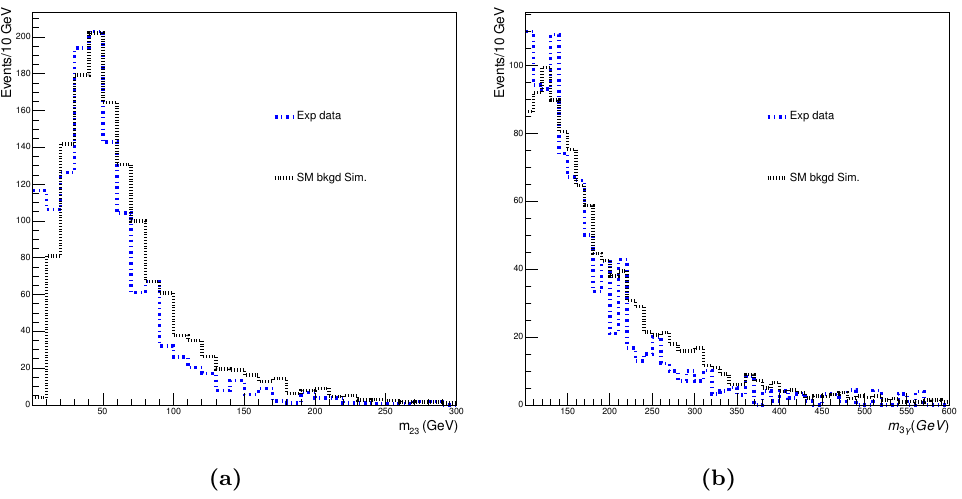
Figure 8. The comparison of the simulated spectra of (a) m 23 and (b) m 3 (cid:13) to those experimental ones is demonstrated.